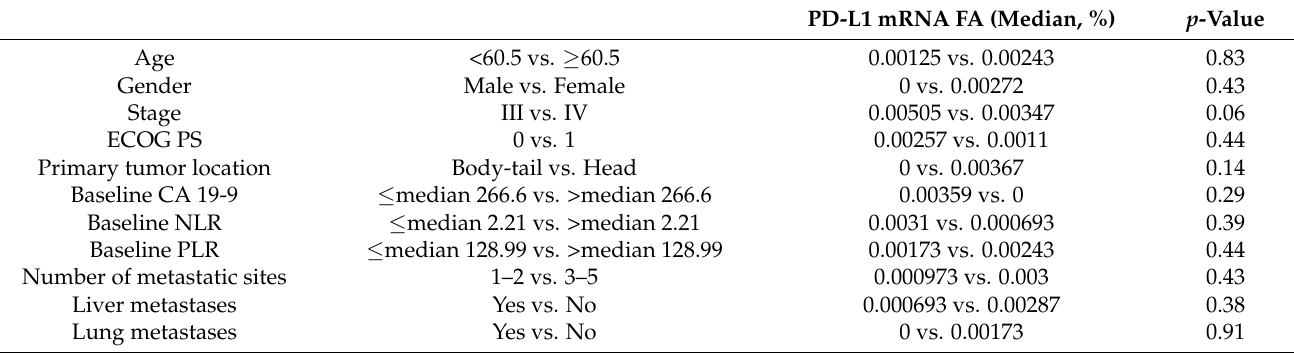
Table 3. Correlation of PD-L1 mRNA levels at baseline with clinical status of patients and laboratory parameters.